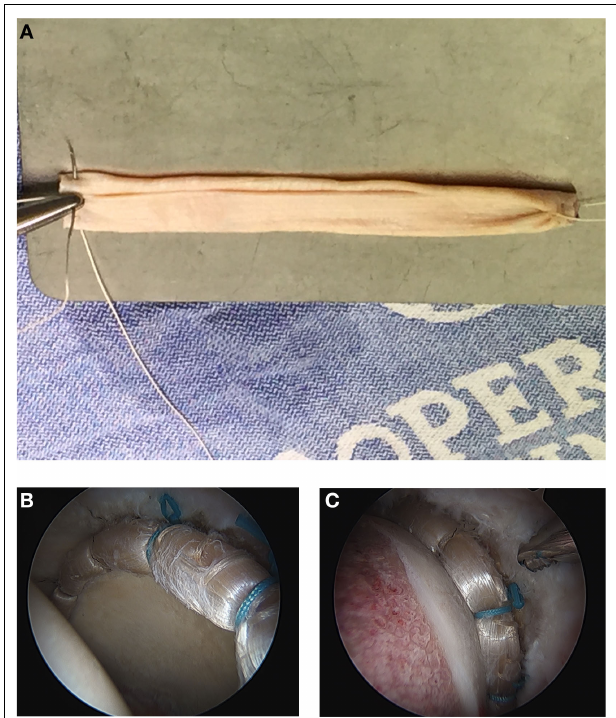
FIGURE 1 | (A) The iliotibial band allograft is measured and rolled to create a final tubularized graft, measuring roughly 5–6 mm in diameter. The graft is folded into thirds and a 2-0 Vicryl suture is placed at each end of the graft using an accordion-type suture technique, where several small bites are taken across the end of the graft. ( B ) After the labral reconstruction, this is a view of a left hip from the anterolateral portal, showing an 11cm labral reconstruction using iliotibial band allograft and nine anchors in traction. ( C ) After the labral reconstruction, this is a view of a left hip from the anteromedial portal showing an 11cm labral reconstruction using iliotibial band allograft and nine anchors. The joint is reduced with a view of the re-established seal between the reconstructed labrum and the femoral